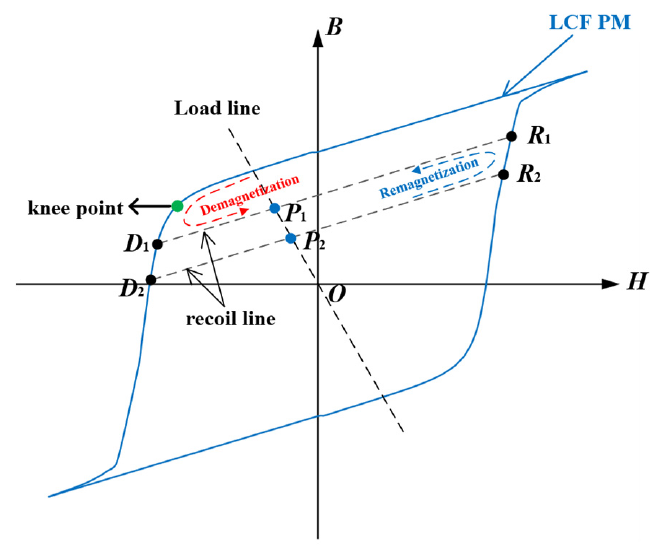
Figure 20. Scheme of the variable flux principle.